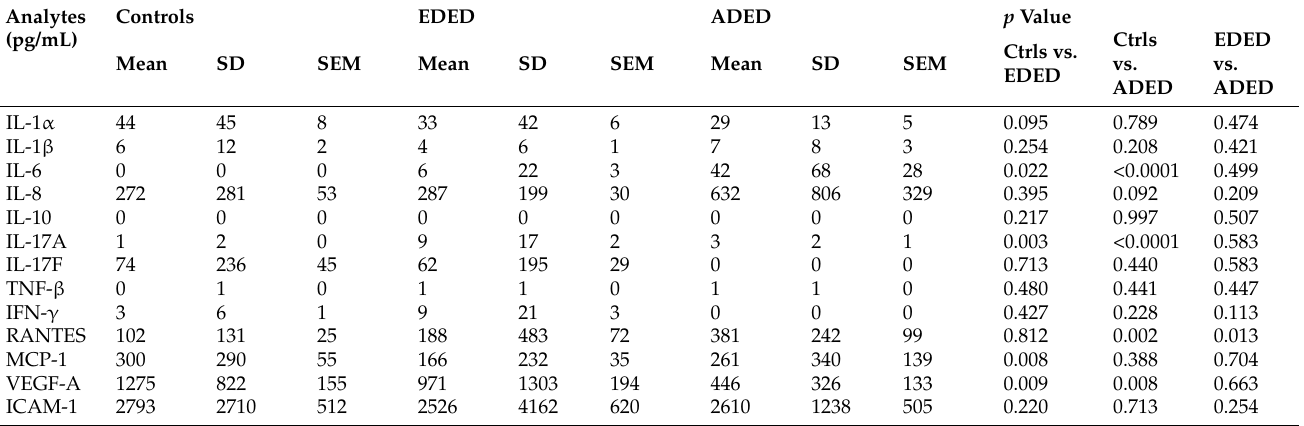
Figure 11. Corneal dendritic cell density in subjects with dry eye disease. Bar graphs represent ( a ) total corneal dendritic cell density (cDCD), ( b ) density of immature forms of corneal dendritic cells and ( c ) density of mature forms of corneal dendritic cells, determined using laser scanning in vivo confocal microscopic images in controls and in subjects with evaporative dry eye disease (EDED) or aqueous deficient dry eye disease (ADED). Controls are subjects without discomfort/symptoms and signs (D - S - ). The number of eyes analysed for corneal dendritic cell density are as follows: Controls (Ctrls): n = 52 eyes; EDED: n = 144 eyes; ADED: n = 48 eyes. The number of eyes analysed for sub-basal nerve plexus features are as follows: Controls (Ctrls): n = 29 eyes; EDED: n = 114 eyes; ADED: n = 32 eyes. * p < 0.05, ** p < 0.01, *** p < 0.01, **** p < 0.0001, Kruskal–Wallis test with Dunn’s multiple comparisons test was performed. Table 2. Tear fluid secreted factors levels in healthy subjects and in patients with evaporative or aqueous deficient dry eye disease.